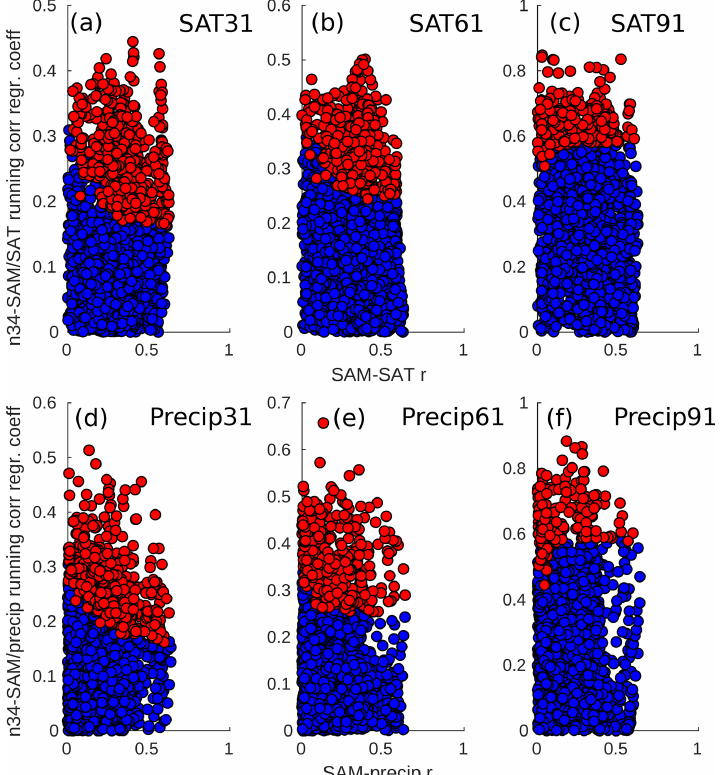
Figure 10. Scatter plots of the regression slopes from the significant (red) and non-significant (blue) land points shown in Figs. 9 and 11 against the 500 year correlation coefficient between the SAM and either the SAT (a, b, c) or the precipitation (d, e, f) . Both the SAM–proxy running correlations for each cell and the n3.4 index are standardised prior to the regression calculation. Note that the vertical scale varies depending on the